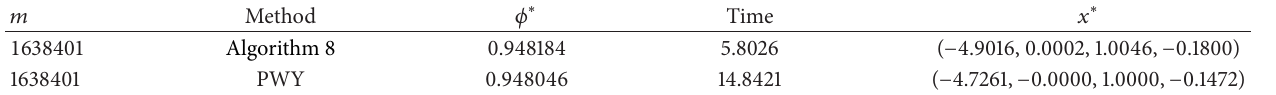
Table 2: Test results for Example 2.